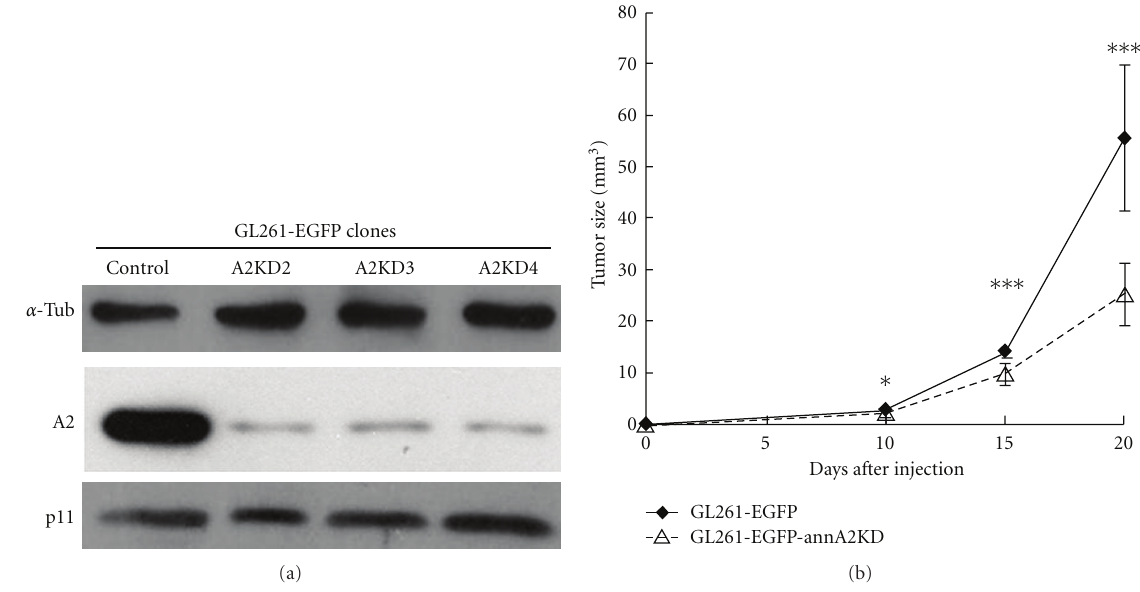
Figure 4: The glioblastoma-promoting e ff ect of A2 is p11 independent. (a) When A2 expression in GL261 murine glioma cells was suppressed with siRNA, p11 expression remained intact. (b) Suppression of A2 expression significantly dampened the growth of intracranial gliomas derived from stereotactically implanted cells. Reproduced with permission